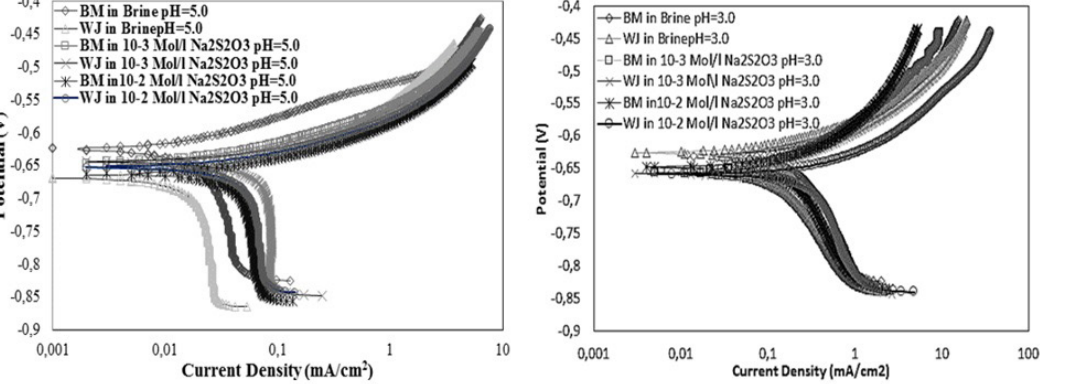
Figure 14. Characteristic Tafel Curve for the base metal and welded joint in different environments with: a) pH=5.0 and b) pH=3.0,